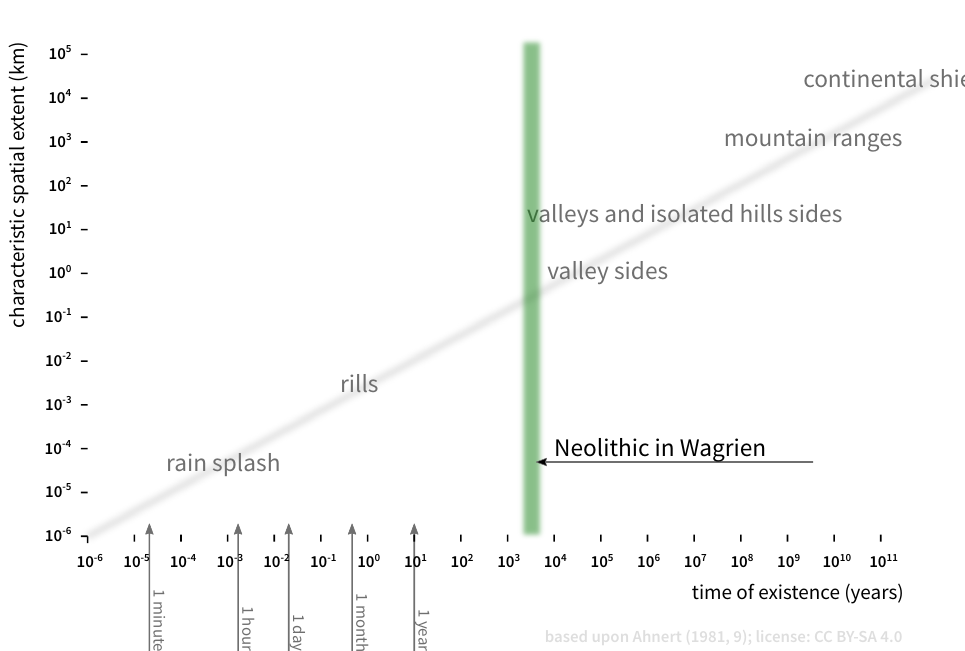
Figure 3. Rule of spatial extent versus duration of existence of selected landforms. The green bar indicates the Neolithic era in Wagrien. It becomes obvious that valleys and larger landforms have apparently existed for a longer period of time than the focus period. Accordingly, it is appropriate to utilize a modern digital elevation model to gain insight into the general structure and character of the